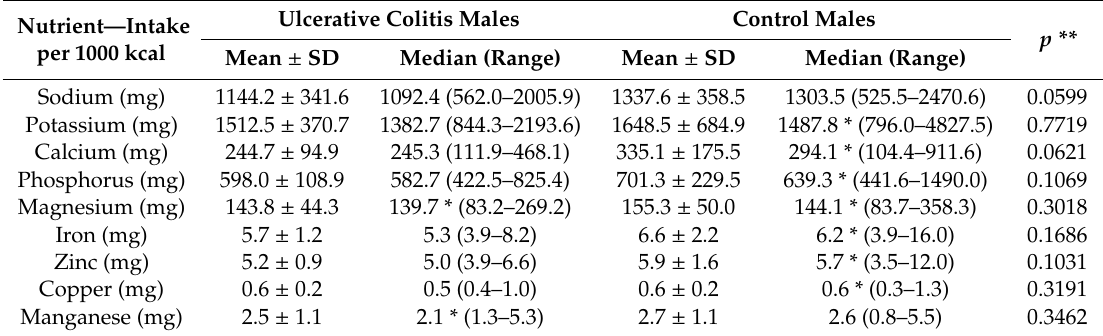
Table 4. The minerals intake per 1000 kcal in ulcerative colitis males and control